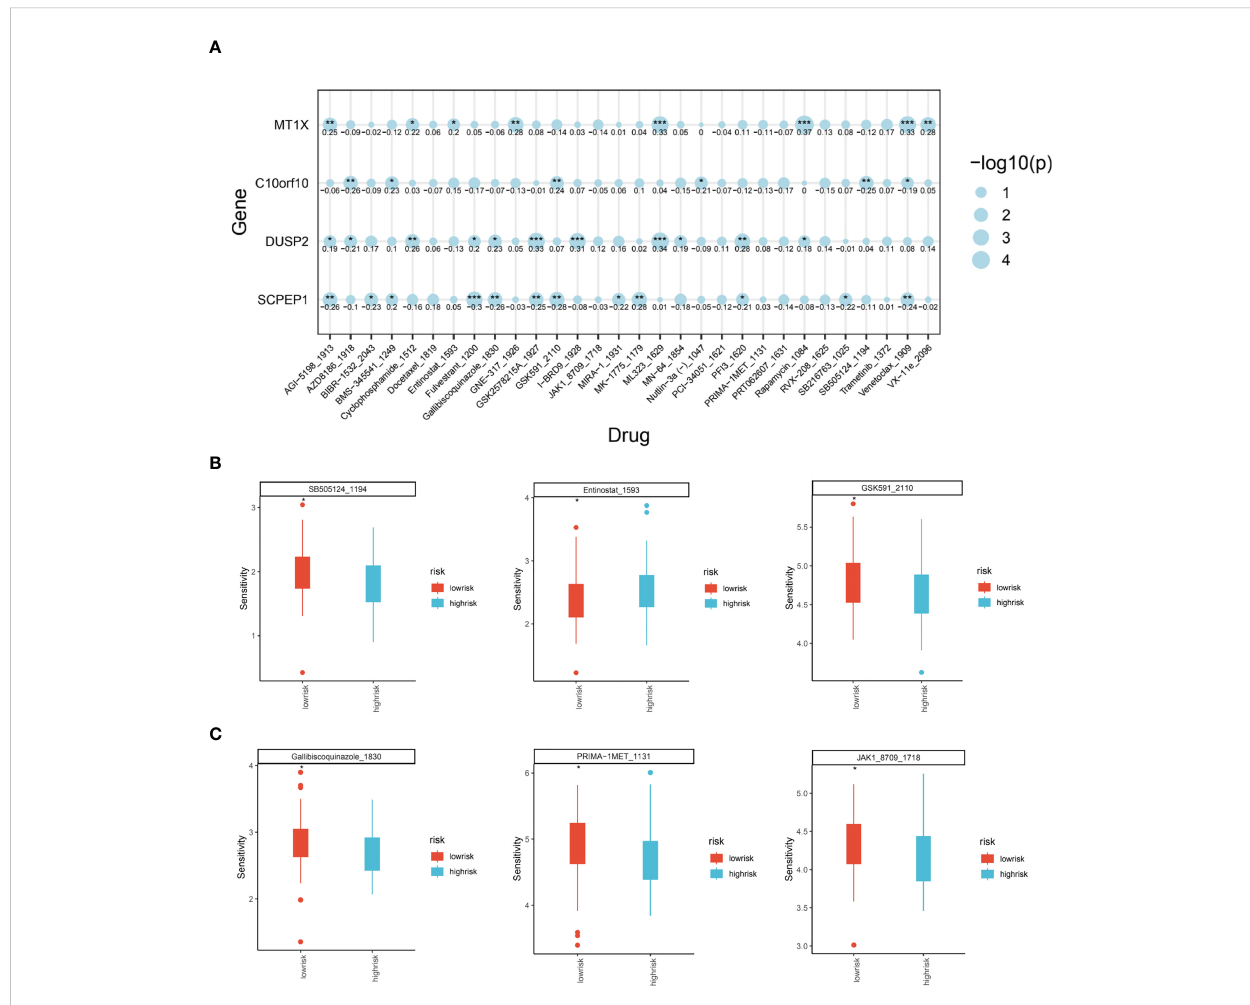
FIGURE 6 Analysis of the role of ESCC lysosomal pathway risk models on tumor treatment sensitivity. (A) Bubble diagram showing the association of four key genes constituting the lysosomal pathway risk model with the therapeutic sensitivity of multiple chemotherapeutic agents: MT1X was associated with AGI-5198_5913, Cyclophosphamide, ML323, Rapamycin, Venetoclax. expression of C10orf10 was signi fi cantly associated with AZD8186, GSDK591, SB505124. GSDK591, SB505124 were signi fi cantly associated. for DUSP2, it was associated with GSK2578215, I-BRD9, ML-323. For SCPEP1, treatment with Fulvetrant, MK-1775, Venetoclax_1909 had a high correlation with it. (B) Box plot of treatment sensitivity between low and high risk groups for lysosomal risk scores for several chemotherapeutic agents, SB505124_1194, Entinostat_1593, GSK591_2110; (C) Gallibiscoquinazole_ 1830, PRIMA-1MET_1131, JAK1_8709_ 1718 Box line plot of treatment sensitivity of these chemotherapeutic agents between low risk and high risk groups for lysosomal risk scores. * means <0.05,** means <0.01,*** means